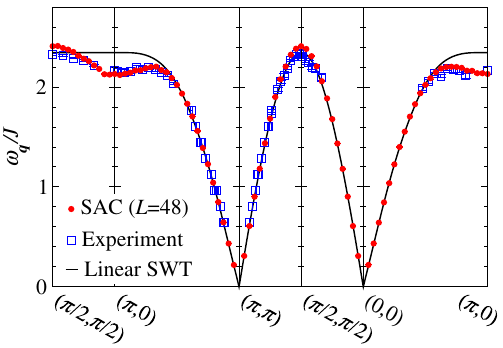
FIG. 9. Single-magnon dispersion ω q along a representative path of the BZ. The CFTD experimental data from Ref. [33] are shown as blue squares, and the QMC-SAC data (the location of the magnon pole) are shown with red circles. We also show the linear SWT dispersion (black curve) adjusted by a common factor corresponding to the exact spin-wave velocity c ¼ 1 . 65847 [65].